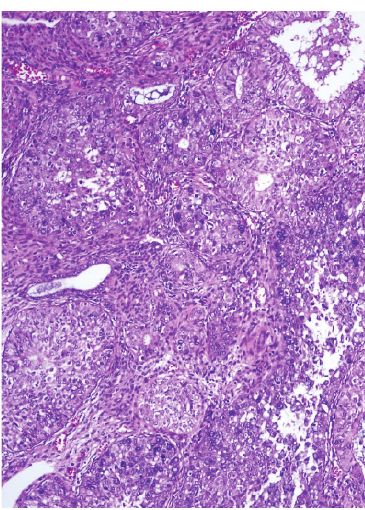
Figure 1: Low grade carcinoma areas and signet-ring cells; H&E × 110.